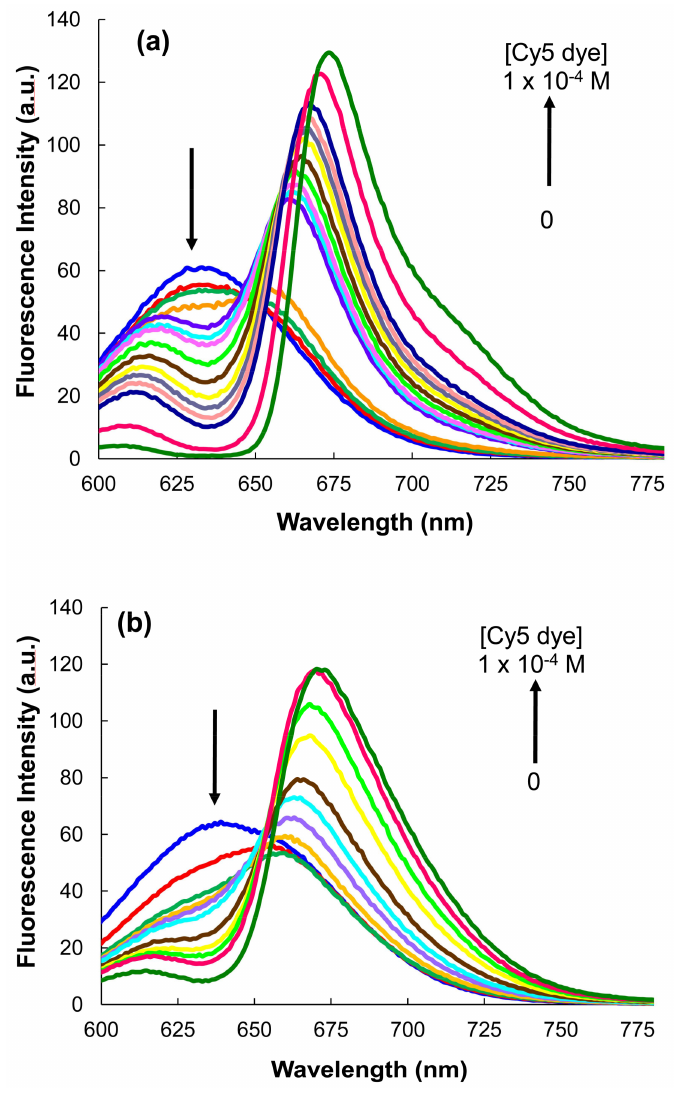
Figure 7. Titration emission spectra of the MPA-capped CdTeSe QDs with the Cy5 dye. ( a ) QDs629 and ( b )